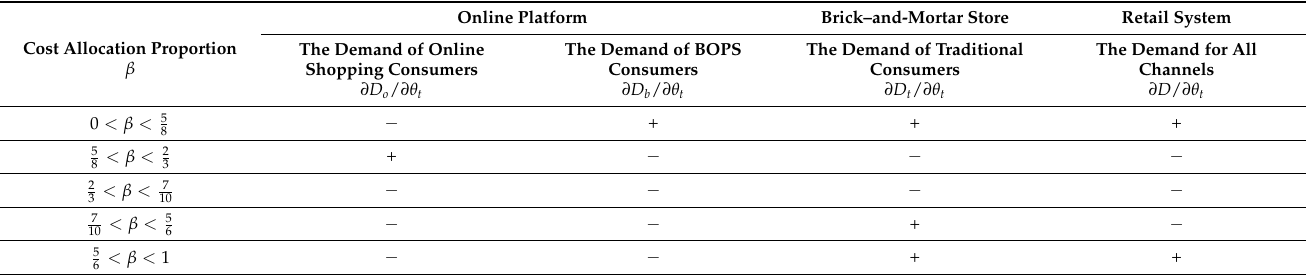
Table 4. Variation of demand with the proportion of traditional